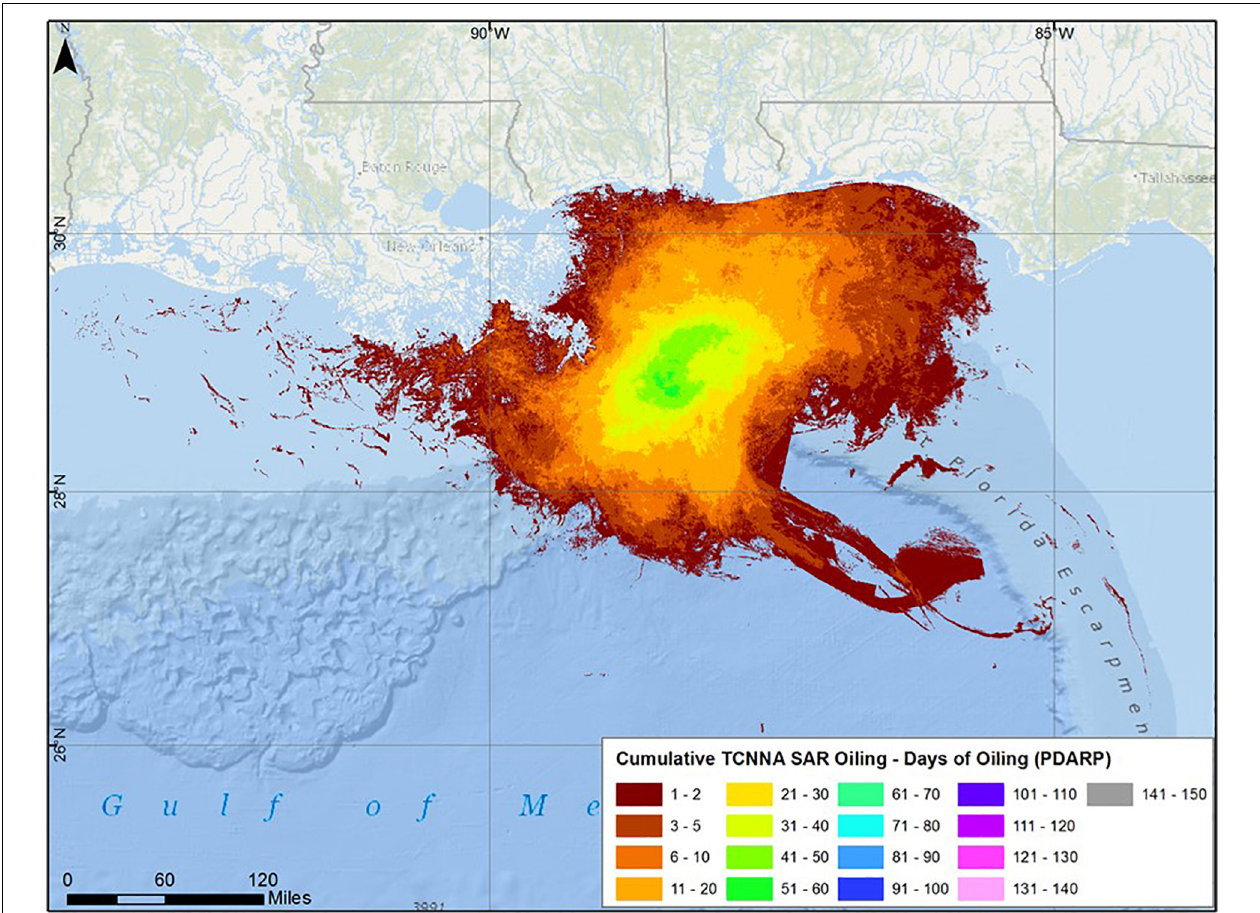
FIGURE 2 | Cumulative days of oil presence on the water surface, based on remote sensing (SAR) analysis (data from ERMA, 2016).